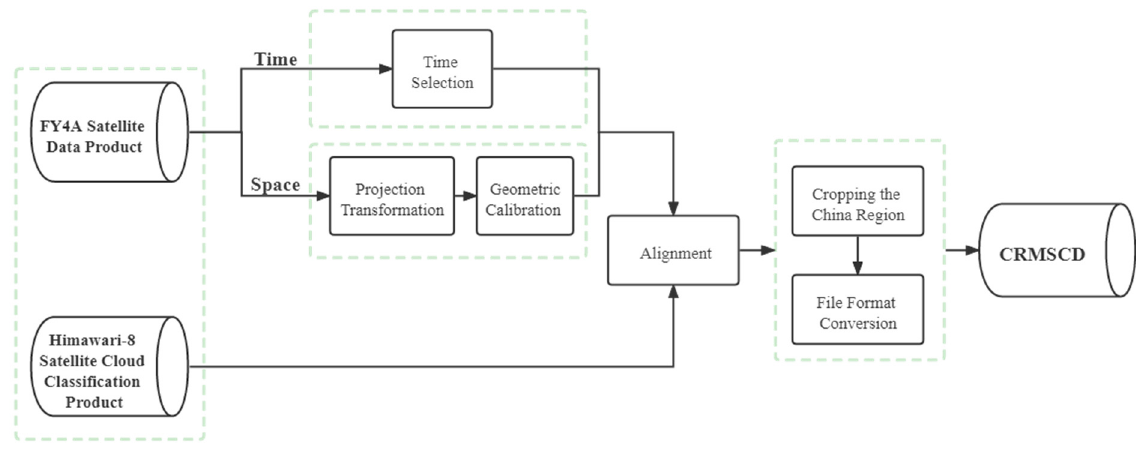
Figure 2. Data processing flow.